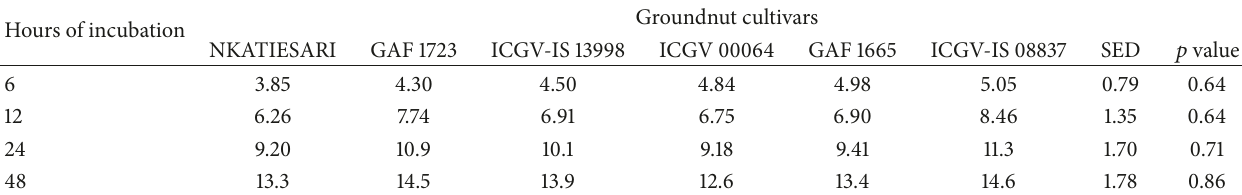
Table 5: In vitro gas production (ml/200mg DM) of fermented groundnut haulm.